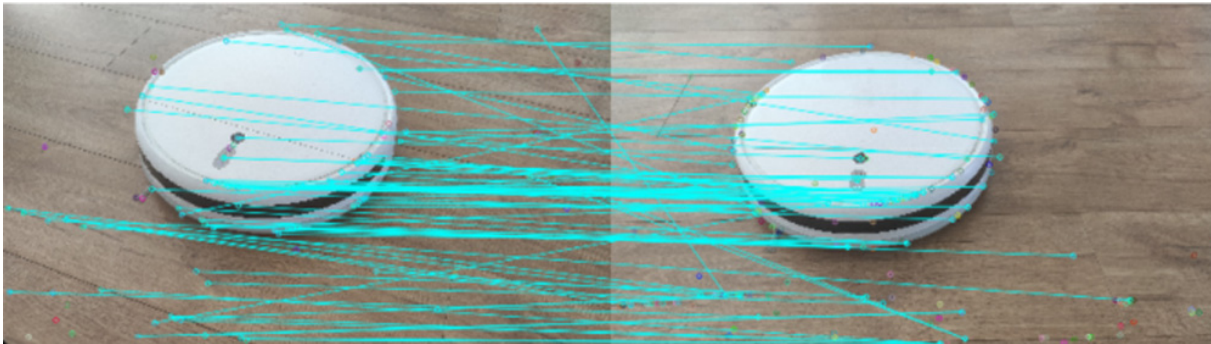
Figure 2. Feature points extraction and matching result of classic SIFT.